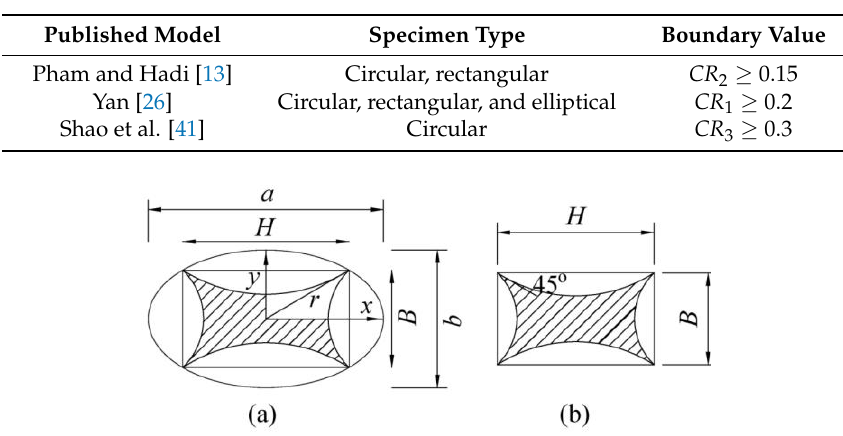
Table 2. Published models of boundary value for sufficiently confined concrete.